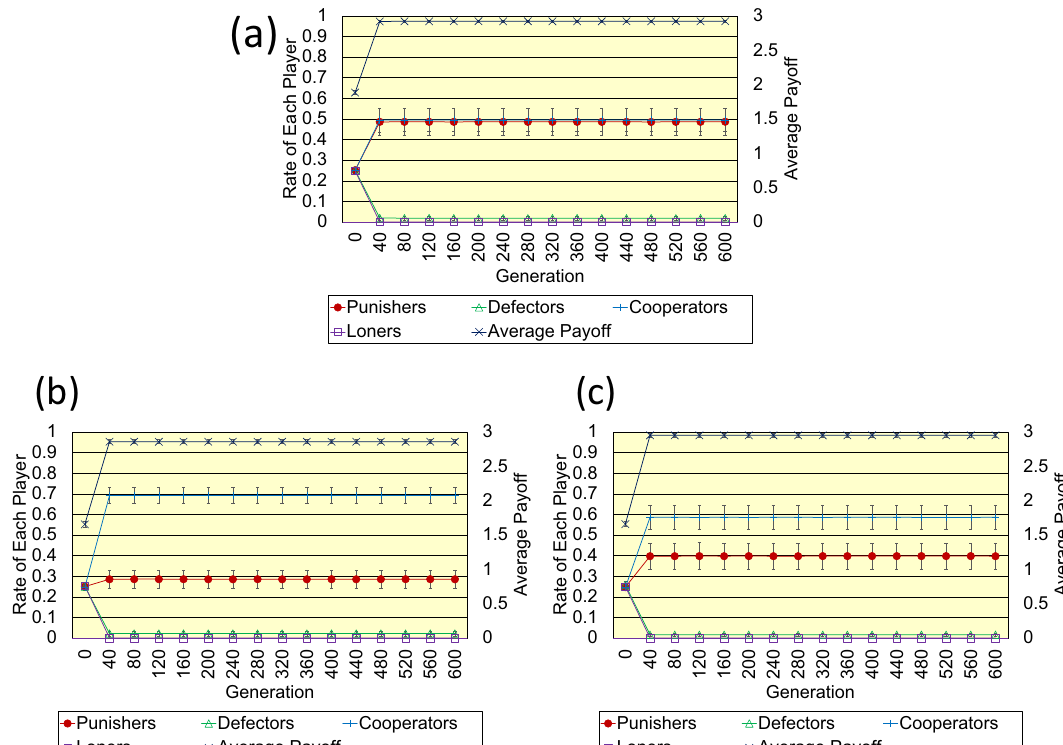
Figure 4. This figure shows the results regarding ( a ) the proposed pool punishment, ( b ) previous pool punishment, and ( c ) previous peer punishment on the random one-dimensional lattice. Parameter settings are as follows; N = 1000, < k > = 4, n = 5, r = 3, c = 1, b = 1, g = 0.3, B = 1, G = 0.3, and σ =